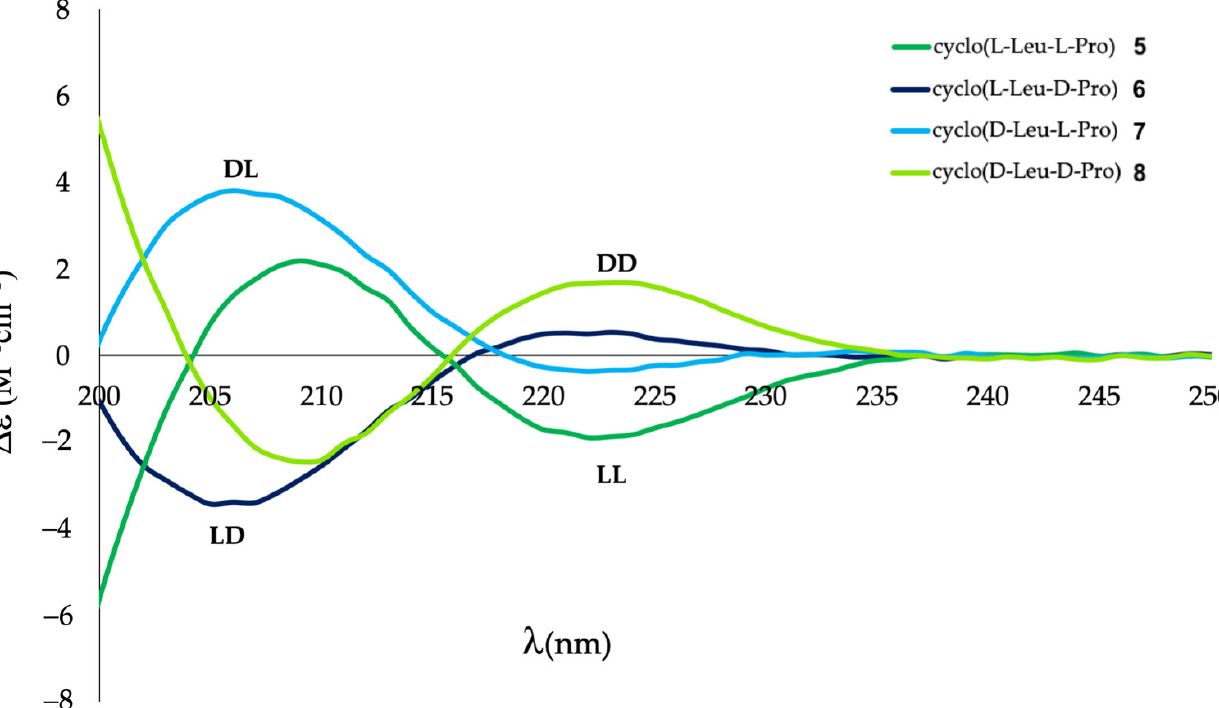
Figure 3. ECD spectra of synthetic cyclo(Leu-Pro) isomers in methanol (spectroscopic grade).